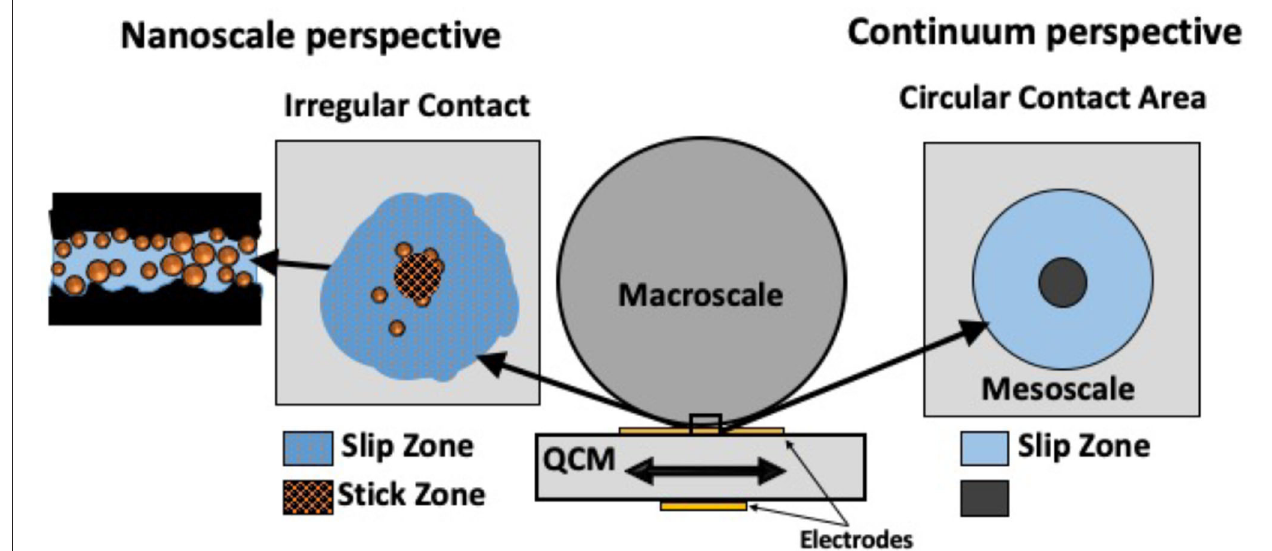
FIGURE 1 | Nanoscale and Continuum perspectives of one ball bearing on an oscillating QCM displaying Cattaneo-Mindlin slip, with the contact area having an inner stick zone and an outer slip